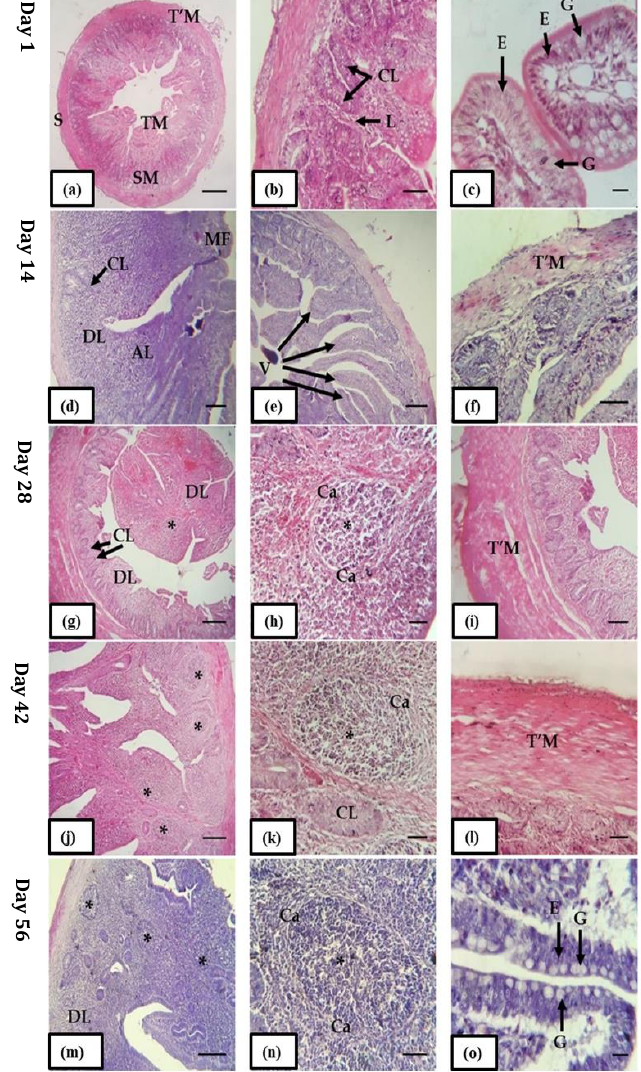
Figure 2 . a : Four histological layers (10×); b : Lymphocytes (L) at lamina propria and submucosa layer (40×); c : Simple columnar epithelium (E) with goblet cells (G) (100×); d : Mucosal fold (MF) (10×); e : The villi (V) (10×); f : Tunica muscularis (T’M) (40×); g : Distinct lymphatic nodules (*) and diffuse lymphocytes (DL) (10×); h : Encapsulated (Ca) lymphatic nodule (*) (40×); i : Tunica muscularis (T’M) (40 ×); j : Lymphatic nodules (*) (10×); k: Partially encapsulated (Ca) lymphatic nodule (*) (40×); l: Tunica muscularis (T’M) (40 ×); m: Diffuse lymphocytes (DL) and lymphatic nodules (*) (10×); n: Fully encapsulated oval shaped lymphatic nodules (*) (40×); o: Simple columnar epithelium with goblet cell in lamina epithelia layer, H & E stain. TM-tunica mucosa, SM- submucosa, T’M -tunica muscularis, S-serosa, CL-crypts of Lieberkühn , Scale bar: 5 µm (10×), 1 µm (40×), 0.5 µm